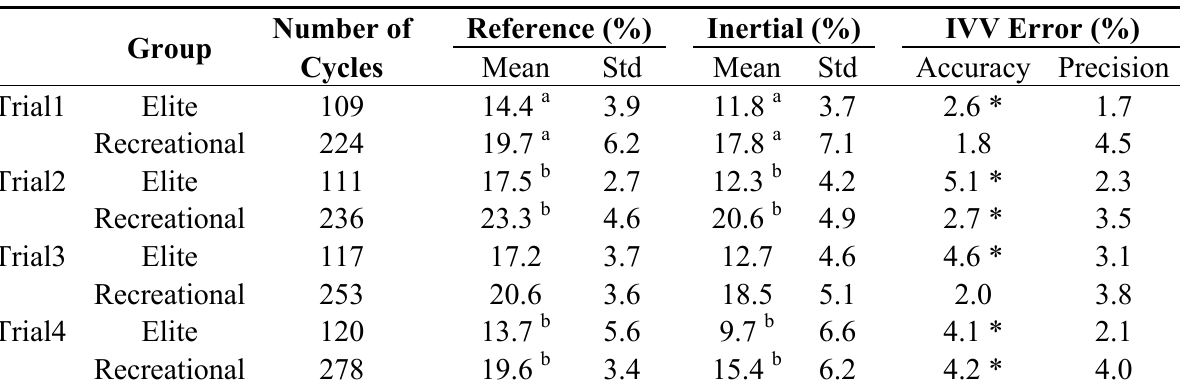
Table 3. Comparison of intra-cyclic velocity variation (IVV) between the two systems for elite and recreational groups in different trials. a p < 0.01 and b p < 0.001 : significant difference between IVV of the two groups for the same measurement system. * p < 0.001 : significant difference between the two systems in IVV